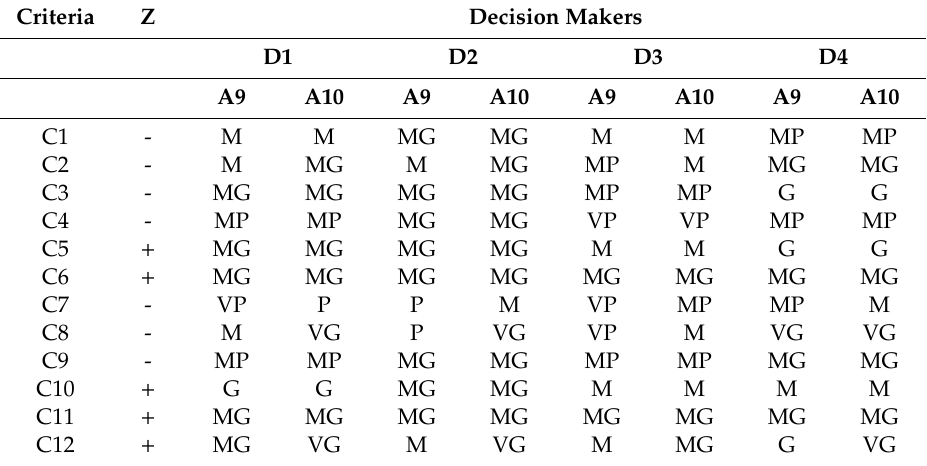
Table A4. Linguistic matrix of alternatives